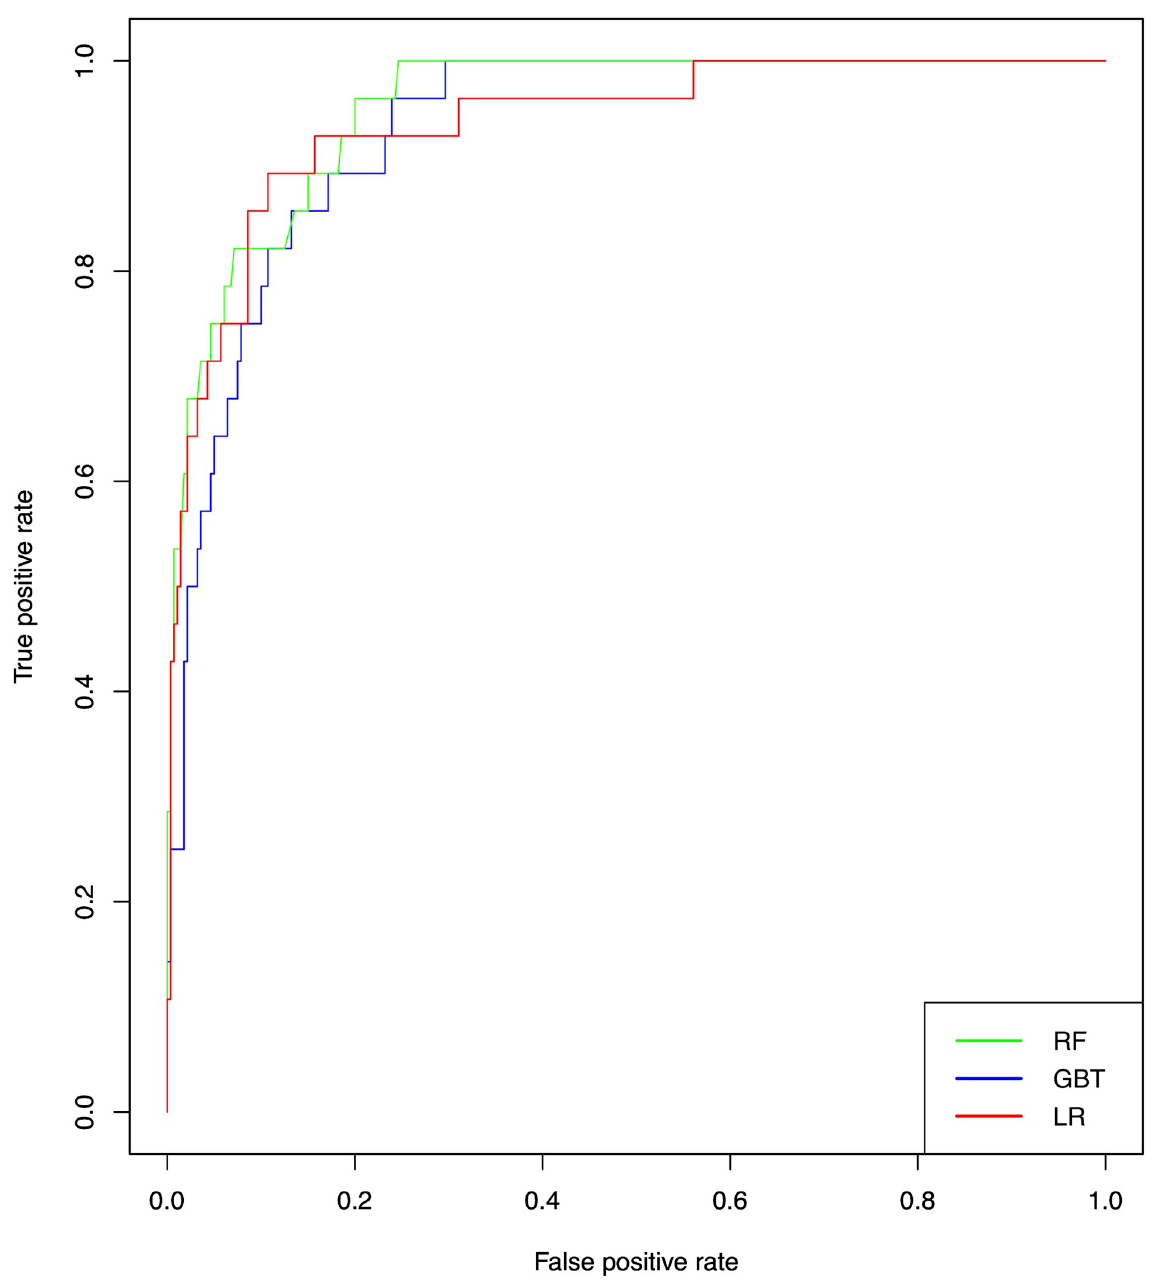
Fig 3. Receiver operating characteristic (ROC) curves in the models for predicting AD. RF = Random Forest; XGBoost = Extreme Gradient Boosting; LR = Logistic Regression.